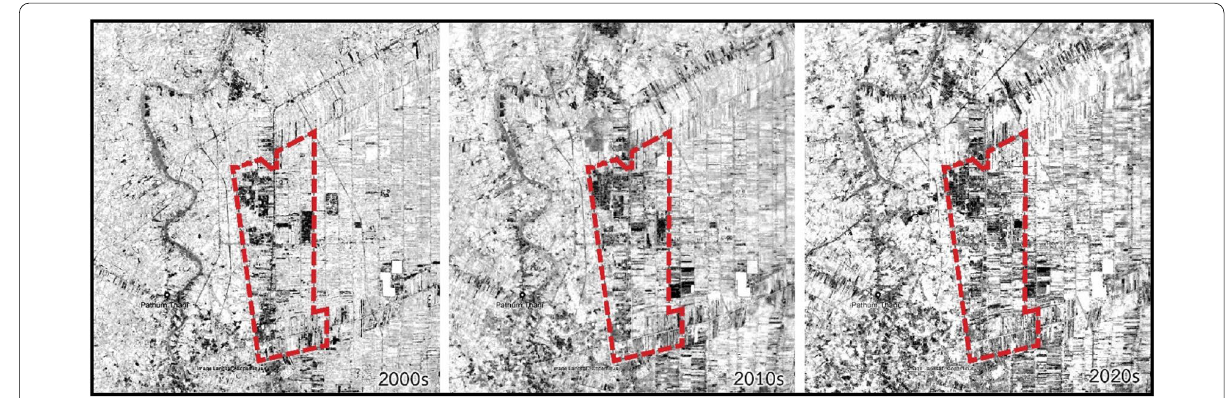
Fig. 3 Expansion of the Thaklong–Klongluang City Councils in 2002, 2010s, and 2020s. (Adapted from Google Map